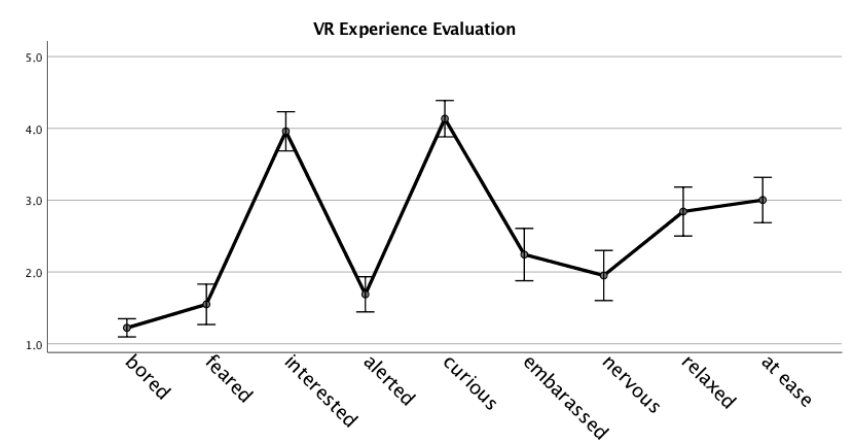
Figure 2. VR experience evaluation. The y-axis represents the mean of each item reported on the x- axis. Bar Errors +/ − 2